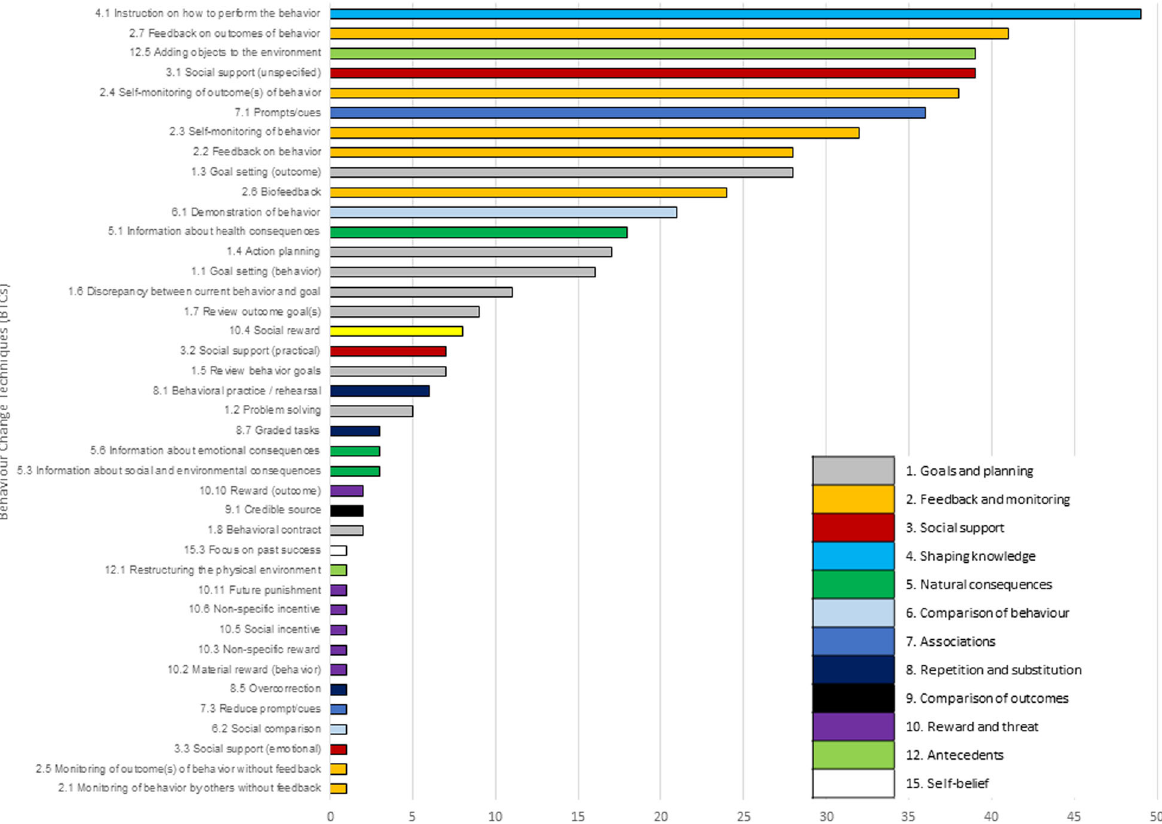
Fig. 2 BCT components adopted. Behaviour Change Techniques components and related clusters included in the selected studies ( n =